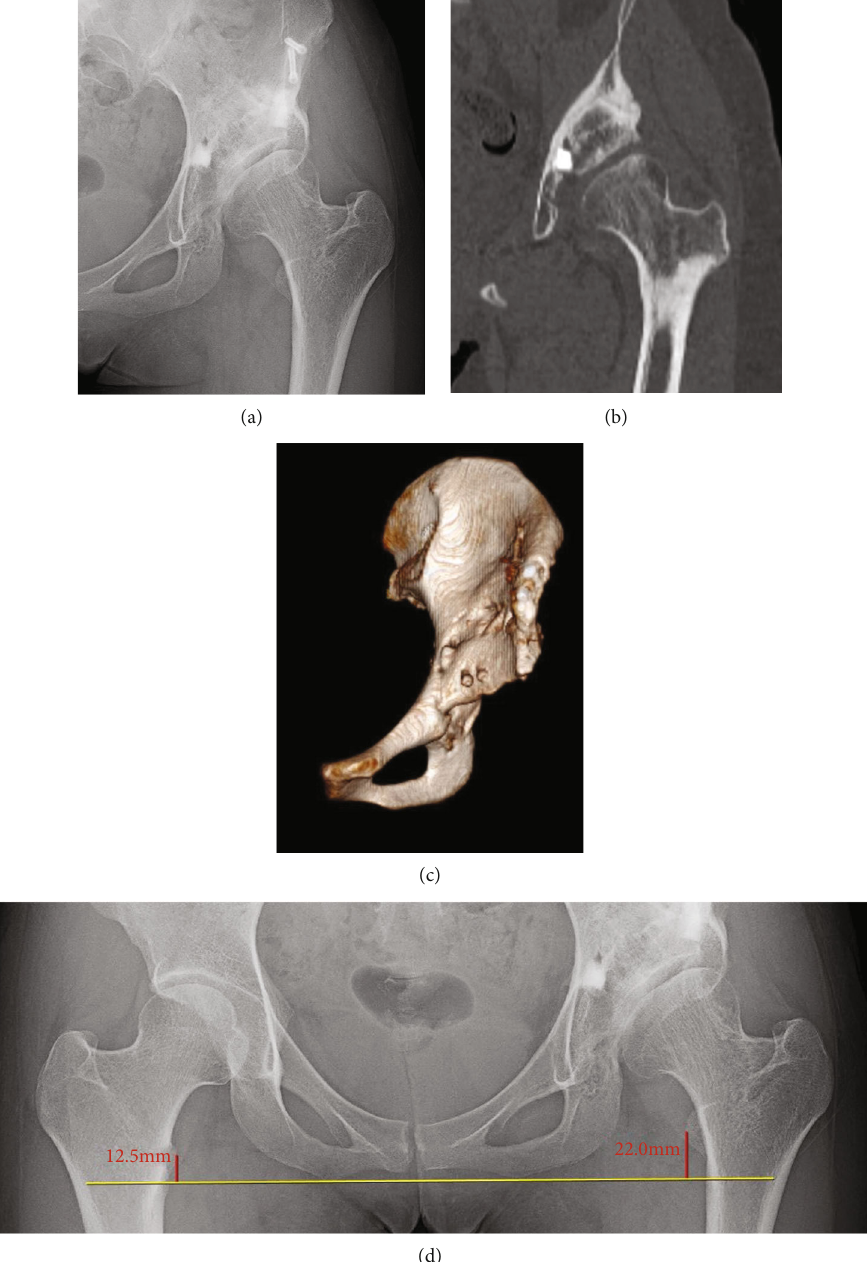
Figure 3: Anteroposterior (AP) radiograph and CT images taken three years after surgery showing the following: (a) AP radiograph of the left hip joint, (b) CT coronal view, and (c) 3D-CT frontal view. Although the superior acetabular coverage was still insu ffi cient, the compatibility of the left hip joint was improved (d). When measured, the postsurgery leg length discrepancy was